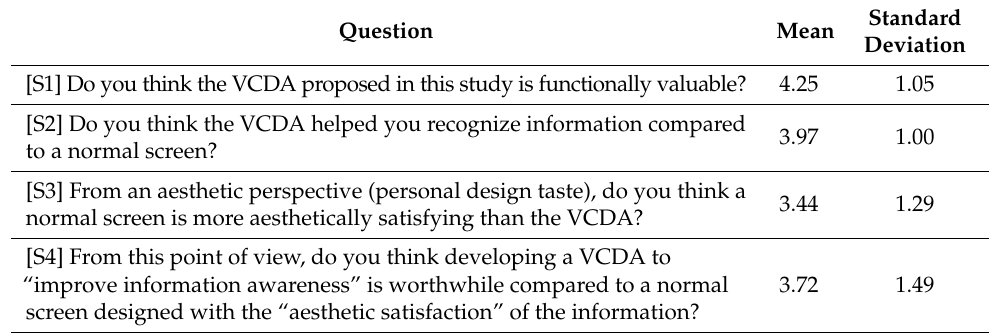
Table 7. VCDA satisfaction survey results.